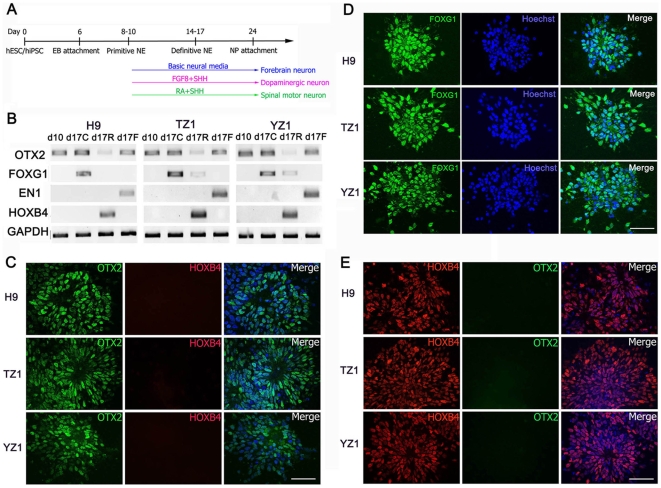
Differentiation of hiPSC/hESC-derived NE cells into region-specific neural progenitors.(A) Schematic for protocols to generate region-specific neural progenitors. (B) RT-PCR analysis for expression of anterior-posterior neural marker genes at days 10 (d10) and 17 (d17) of neural differentiation from H9 hESC and TZ1 and YZ1 hiPSC lines. The day-17 cells were treated with RA (d17R) or FGF8 (d17F) for the last 7 days with untreated cells as a control (d17C). (C & D) Immunostaining for OTX2 and HOXB4 (C) or FOXG1 (D) on neural progenitors differentiated for 25 days from H9, TZ1, and YZ1. Cell nuclei were counterstained with Hoechst 33342. Bar, 50 µm. (E) The same staining on neural progenitors differentiated for 25 days from the 3 cell lines that were treated with RA.